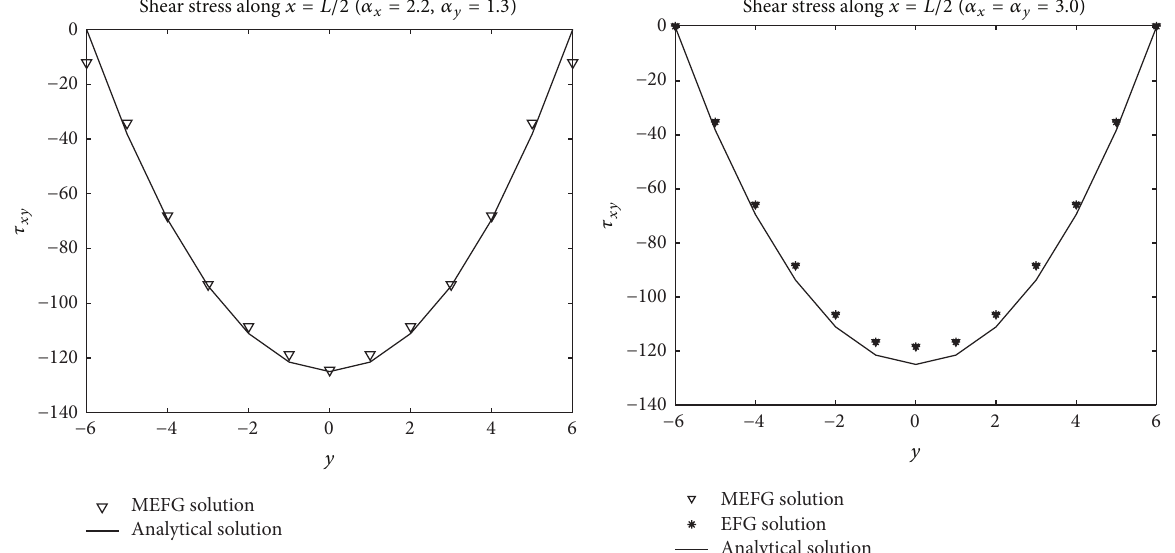
Figure 5: Comparison of shear stress along 𝑥 = 𝐿/2 between analytical and numerical solution.